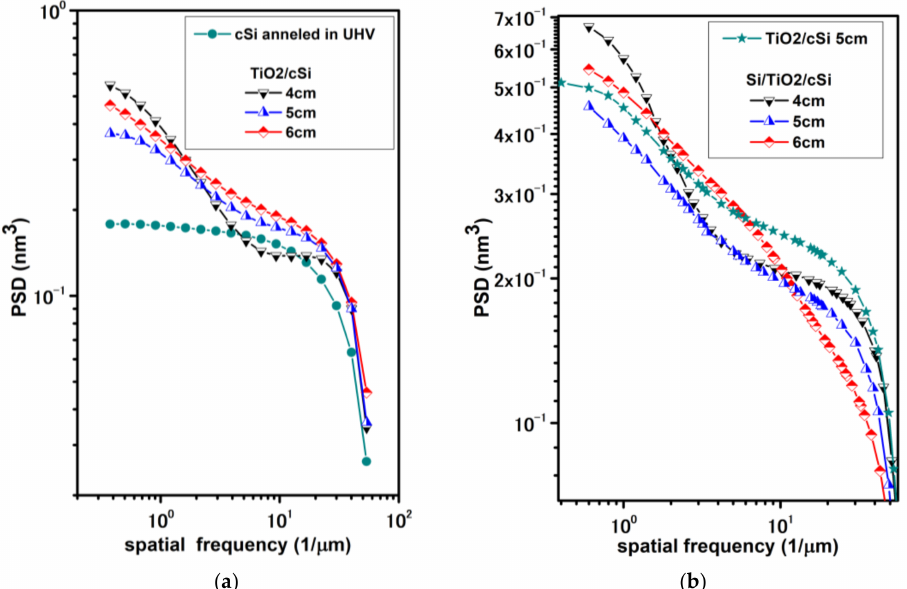
Figure 4. ( a ) The PSD function of TiO 2 thin films deposited on crystalline silicon (c-Si) substrate (green) at different d TS of 4, 5, and 6 cm. ( b ) The PSD of Si film deposited onto previous TiO 2 layer at the same d TS values. PSD of TiO 2 /c-Si structure considered as substrate for Si layer deposition at d TS = 5 cm (green) is given to reveal the changes on surface topography of the prepared